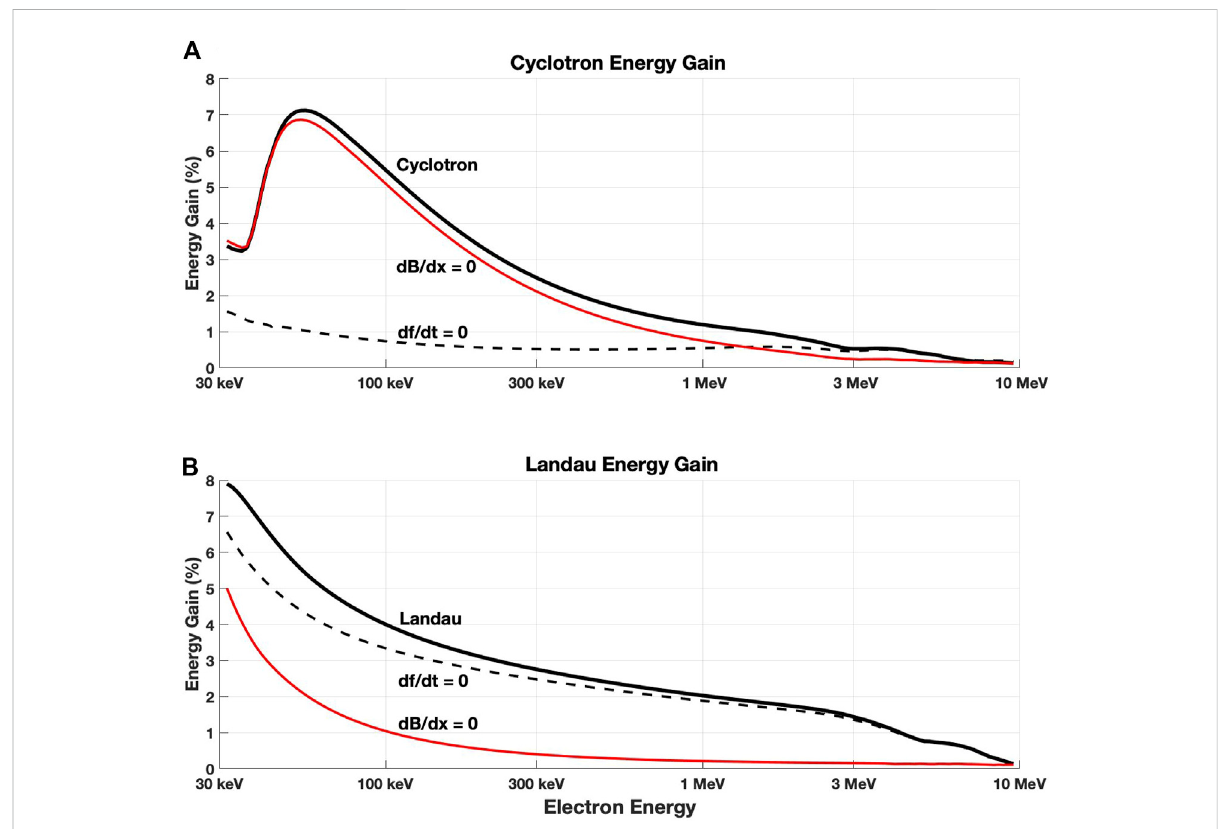
FIGURE 10 Percent energy gain (solid black curves) for electrons with for 30 keV – 10 MeV initial energy in cyclotron (A) or Landau (B) resonance is shown assuming the electrons remain trapped across the 11 ms subpacket indicated in Figure 4. Panels (A) and (B) respectively show the S-factor dependencies of the cyclotron and Landau energization. For the black dashed curves in both panels the contribution to the electron energization from only the dB/dx gradient term is shown (df/dt has been set to zero). For the red curves the dB/dx terms have been set to zero in the inhomogeneity factors such that the only the contribution to the electron energization is from the frequency